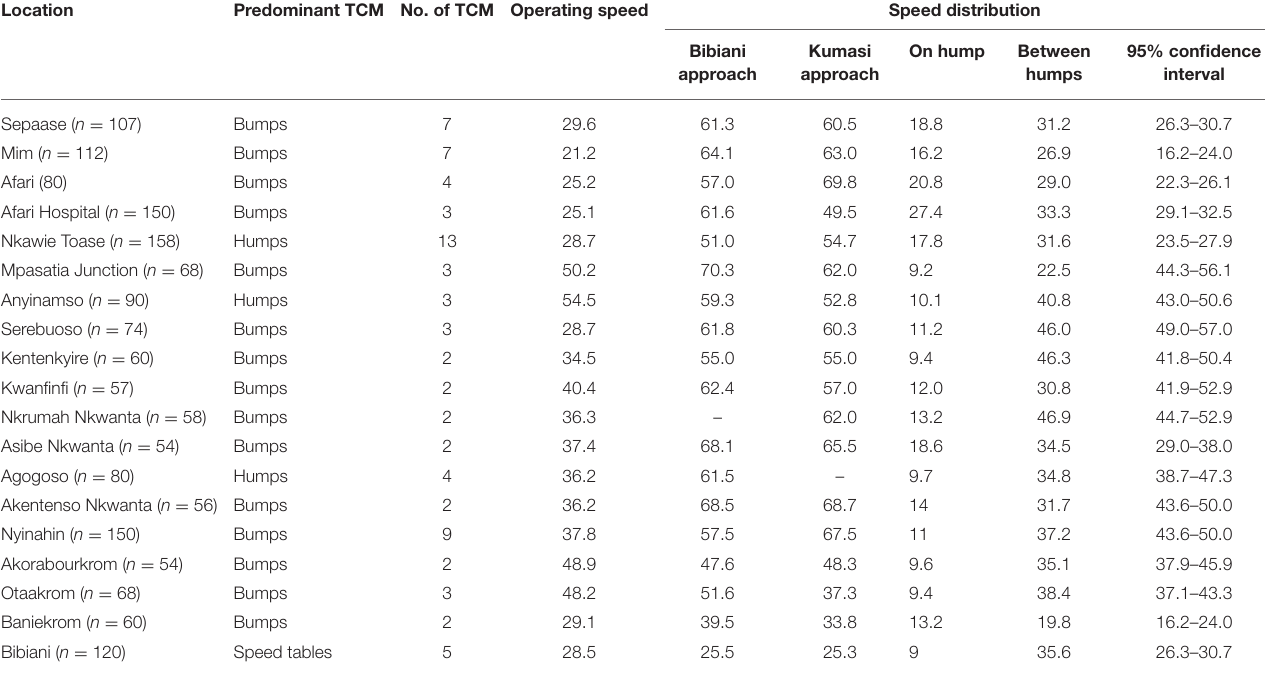
TABLE 2 | Distributions of vehicle speeds on Abuakwa-Bibiani Highway. Location